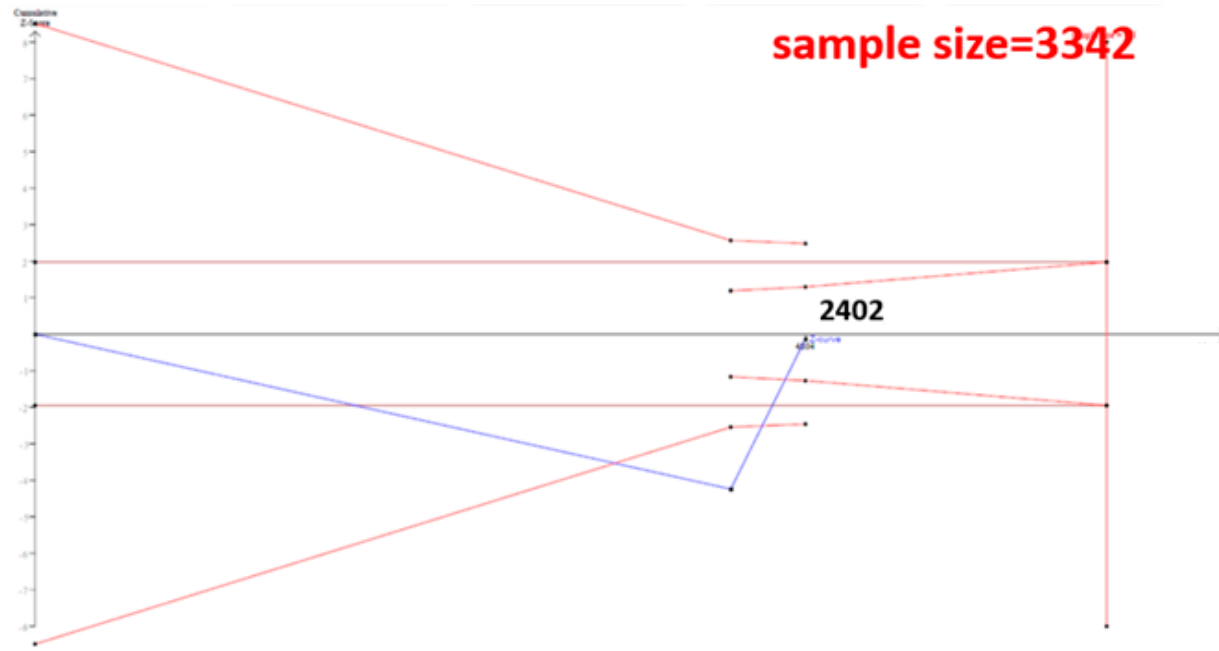
Figure 4. Trial Sequential Analysis (TSA) in Caucasians. We performed a TSA using an allele model assumption but replaced the allele count with the sample size (divided by 2). Detailed settings: Significance level = 0.05; Power = 0.8; ratio of controls to cases = 1; hypothetical proportion of controls with G allele = 0.31; least extreme OR to be detected = 1.5; I 2 (heterogeneity) =